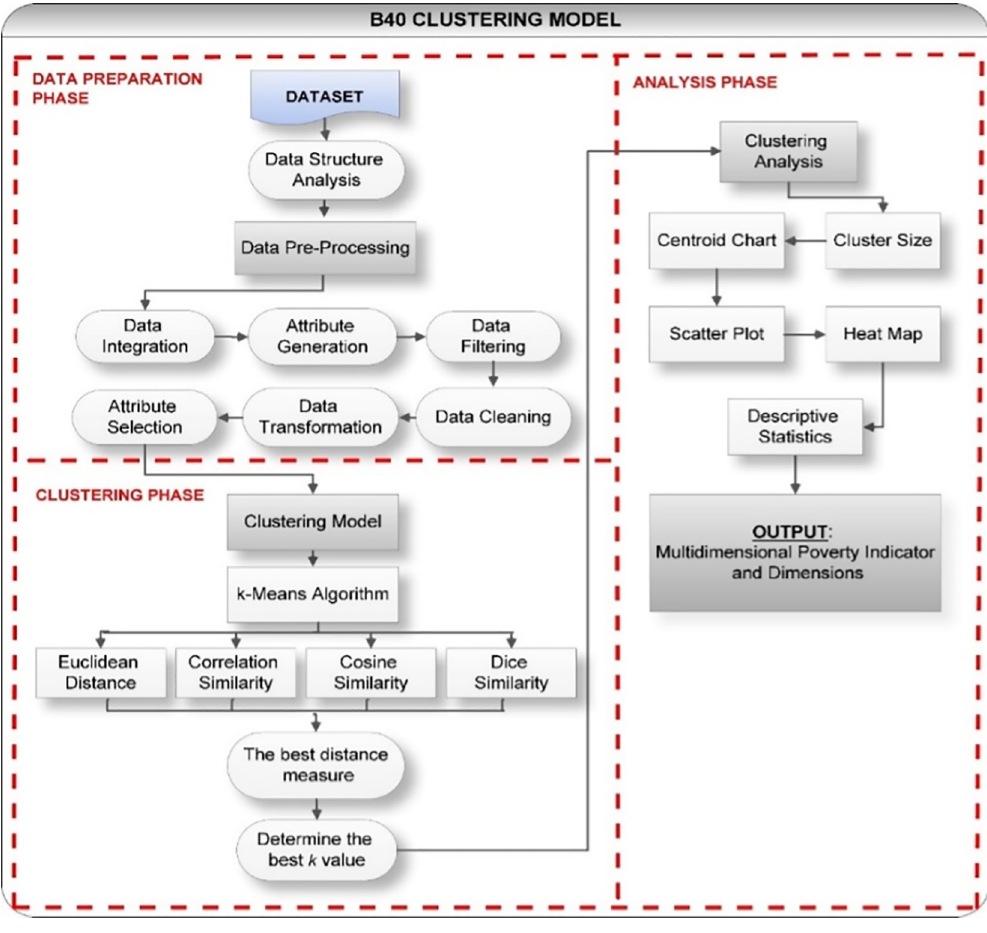
Fig 1. The workflow for the B40 clustering